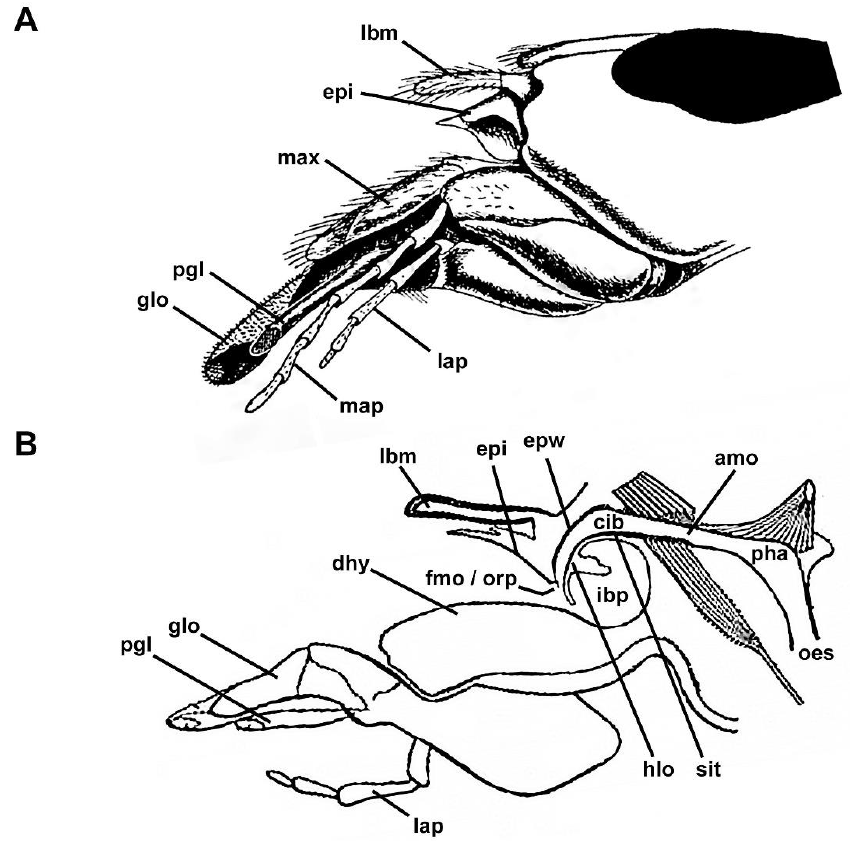
Figure 1. Schematic drawings of the Vespinae mouthparts and preoral cavity. ( A ) Lateral view at the head and mouthparts, without the mandible, edited from Kirmayer (1909). ( B ) Lateral view at the internal anatomy of the preoral cavity, edited from Duncan (1939). [Abbreviations: amo: